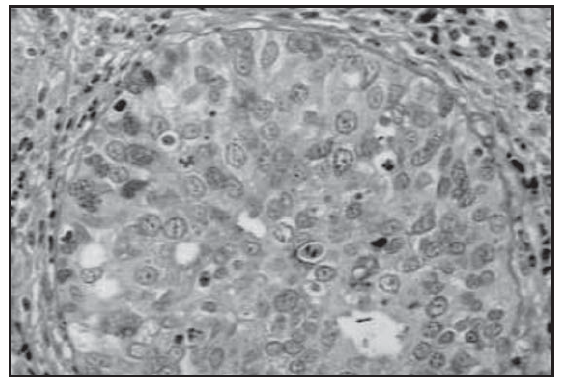
Figura 8 – SMILE encontrada no epitélio de uma glândula na superfície tumoral. Células atípicas imaturas estão presentes em toda a espessura epitelial, sendo intercaladas por focos de mucina identifi cados pela coloração de ácido periódico de Schiff (PAS, 200x)